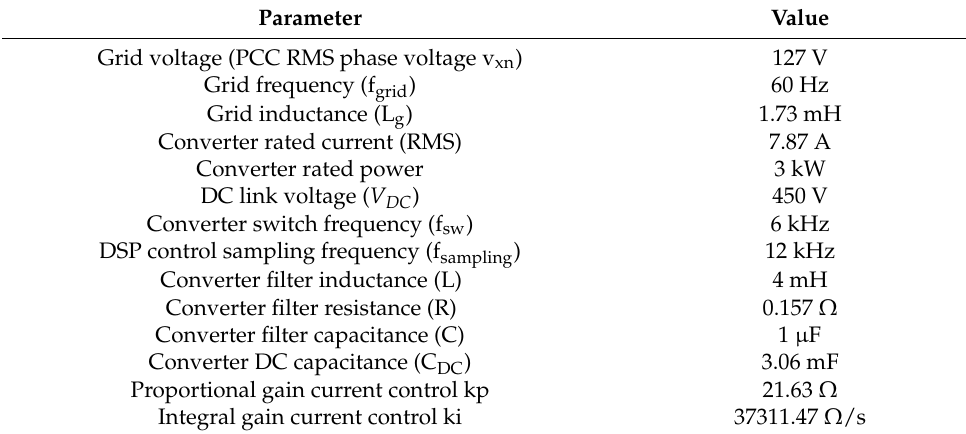
Table 2. Parameters of experimental